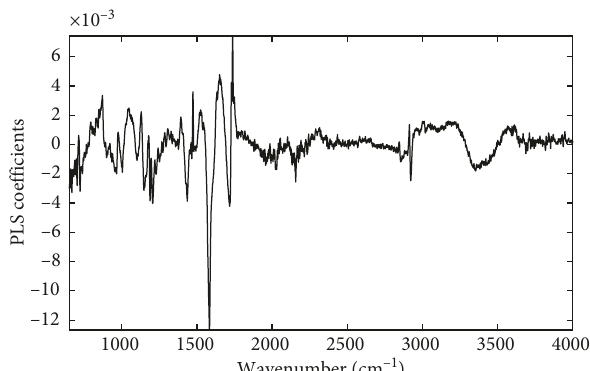
Figure 6: External prediction output of the partial least-squares- model. The line at 0.5 was the criteria of the PLS-DA model to determine the sample